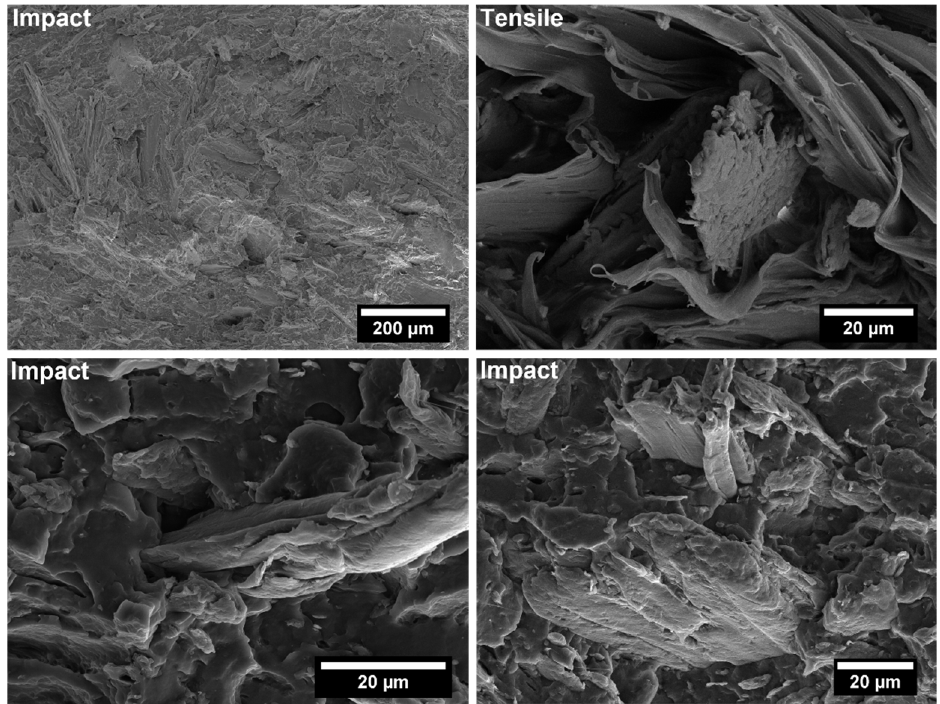
Figure 15. SEM micrographs of PP-based biocomposites with 30 wt.% of willow fillers without coupling agent after tensile and Charpy impact tests.